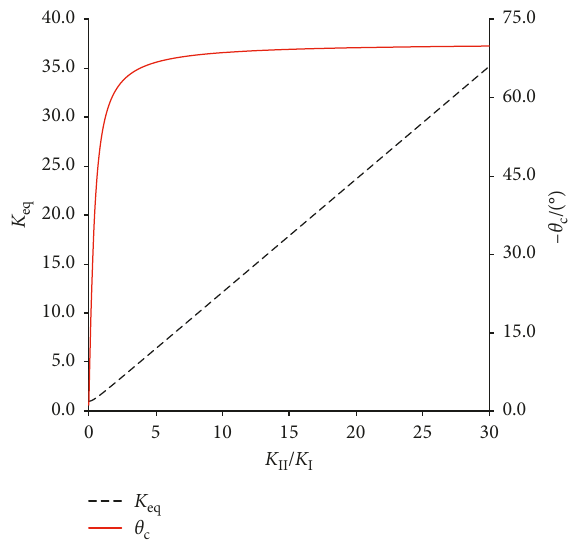
Figure 10: Effect of stress intensity factor on the critical initiation angle and equivalent stress intensity